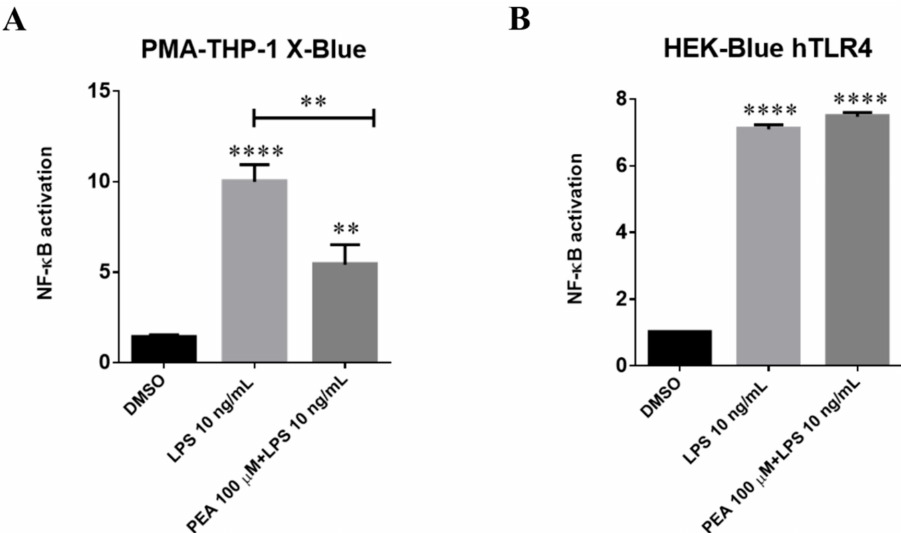
Figure 11. Inhibition of nuclear factor kappa-light-chain-enhancer of activated B cells (NF- κ B) activation in LPS-stimulated PMA-THP-1 X-Blue cells by PEA. PMA-THP-1 X-Blue ( A ) and HEK- Blue hTLR4 ( B ) cells were incubated with 100 µ M PEA at 1 h before treatment with 10 ng/mL LPS. The amount of secreted embryonic alkaline phosphatase (SEAP) released into the culture medium was quantified after 6 h as a measure of NF- κ B activation. Data are presented as mean ± S.E.M. ( n = 3 independent experiments) normalized on the control sample. Differences between groups were tested for significance by applying the ANOVA test and Tukey post hoc test. ** p < 0.01, **** p <